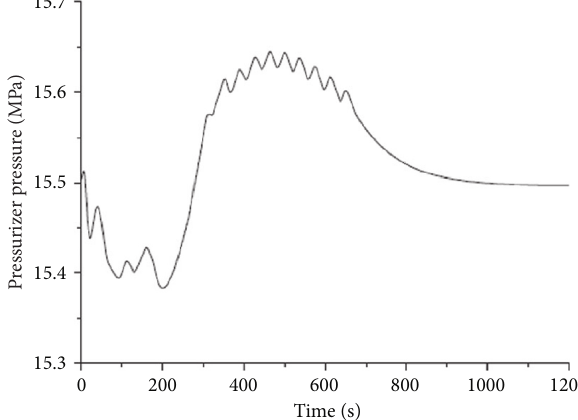
Figure 5: The change in the transient pressure of a pressurizer with a linear increase in the load.